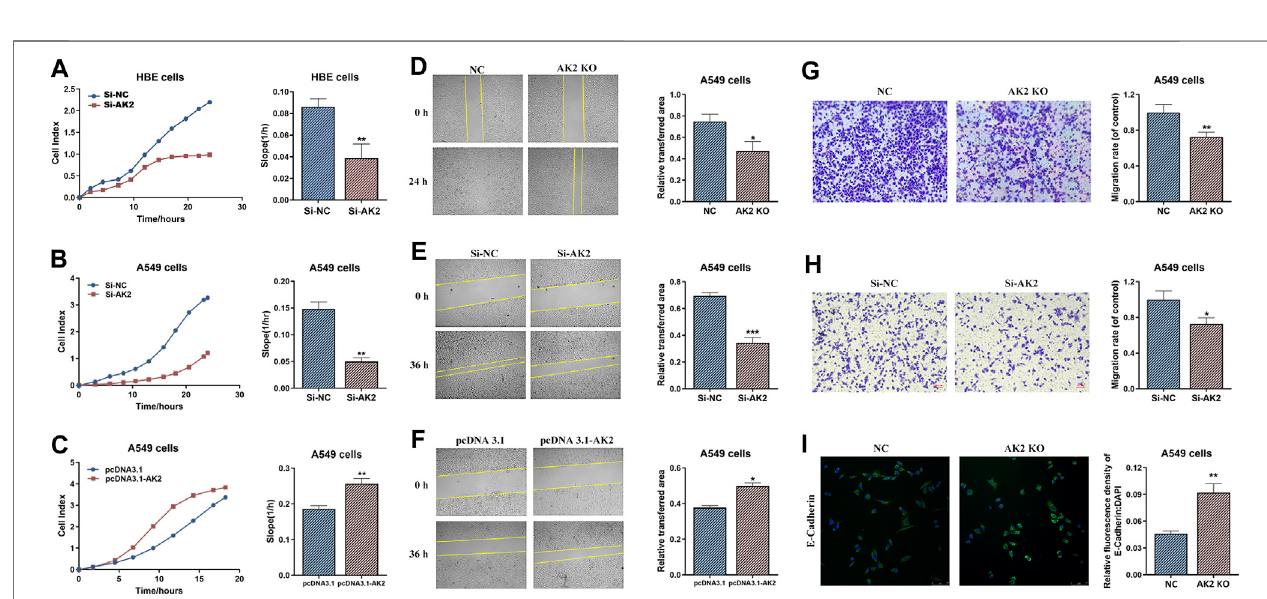
FIGURE 2 | Knockout or knockdown of AK2 signi fi cantly inhibits lung cancer cell migration and invasion. (A – C) RTCA analysis on migration ability of AK2- knockdown HBE cells (A) , AK2-knockdown A549 cells (B) and AK2-overexpression (pRK5-HA-AK2) A549 cells (C) , respectively. Each bar is the mean of three independent experiments. Data are represented as mean ± S.D. ** p < 0.01. (D – F) Wound healing assay on migration ability of AK2-knockout A549 cells (D) , AK2- knockdown(transfectedwithAK2siRNA)A549cells (E) ,andAK2-overexpression(pRK5-HA-AK2)A549cells (F) ,respectively.Photographsweretakenat0,24or 36 h post scratch creation. Images shown are representative of three independent experiments. Data are represented as mean ± S.D. * p < 0.05, *** p < 0.005. (G,H) Transwell assay on invasion capabilityof AK2-knockout A549 cells (G) and AK2-knockdown (transfected with AK2 siRNA) A549 cells (H) . After 16 h, cells that migrated to the inferior membrane were stained and counted in fi ve fi elds at a magni fi cation of × 100. N (cid:2) 3, bar (cid:2) 50 μ m. The experiments were carried out in triplicate and representative data were shown. Data are represented as mean ± S.D. * p < 0.05, ** p < 0.01. (I) Immuno fl uorescence assay was used to detect the expression of EMT marker protein E-cadherin (200 × ) in AK2-knockout A549